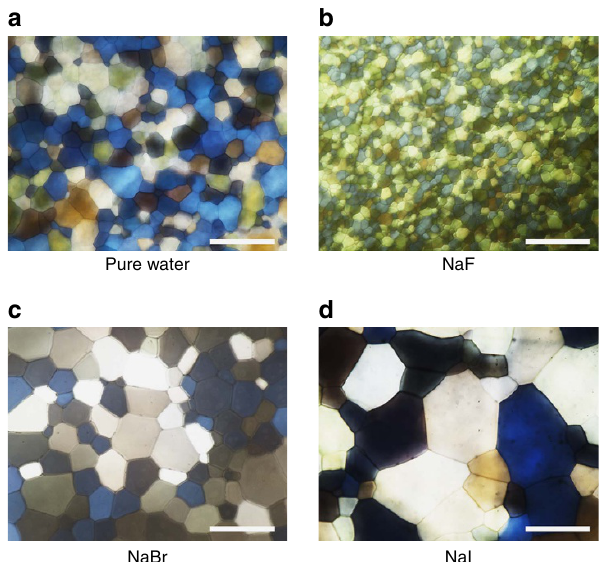
Figure 1 | Polarized optical microscopy images of polycrystalline ice crystals. ( a – d ) show the typical grain size of ice crystals after rapid freezing and annealing at a higher temperature of pure water, NaF, NaBr and NaI aqueous solutions, respectively. Clearly, anions have a distinct effect on ice recrystallization. Aqueous solution droplets (20 m l) were dropped onto a silicon wafer substrate from a height of 1.5m. The wafer surface temperature was (cid:2) 60 (cid:2) C, and the substrate was placed in a N 2 environment to prevent water condensation and ice formation. Then, the ice crystals were annealed at (cid:2) 6 (cid:2) C for 45min. The concentration of the salt solution was 0.01M. The scale bar is 200 m